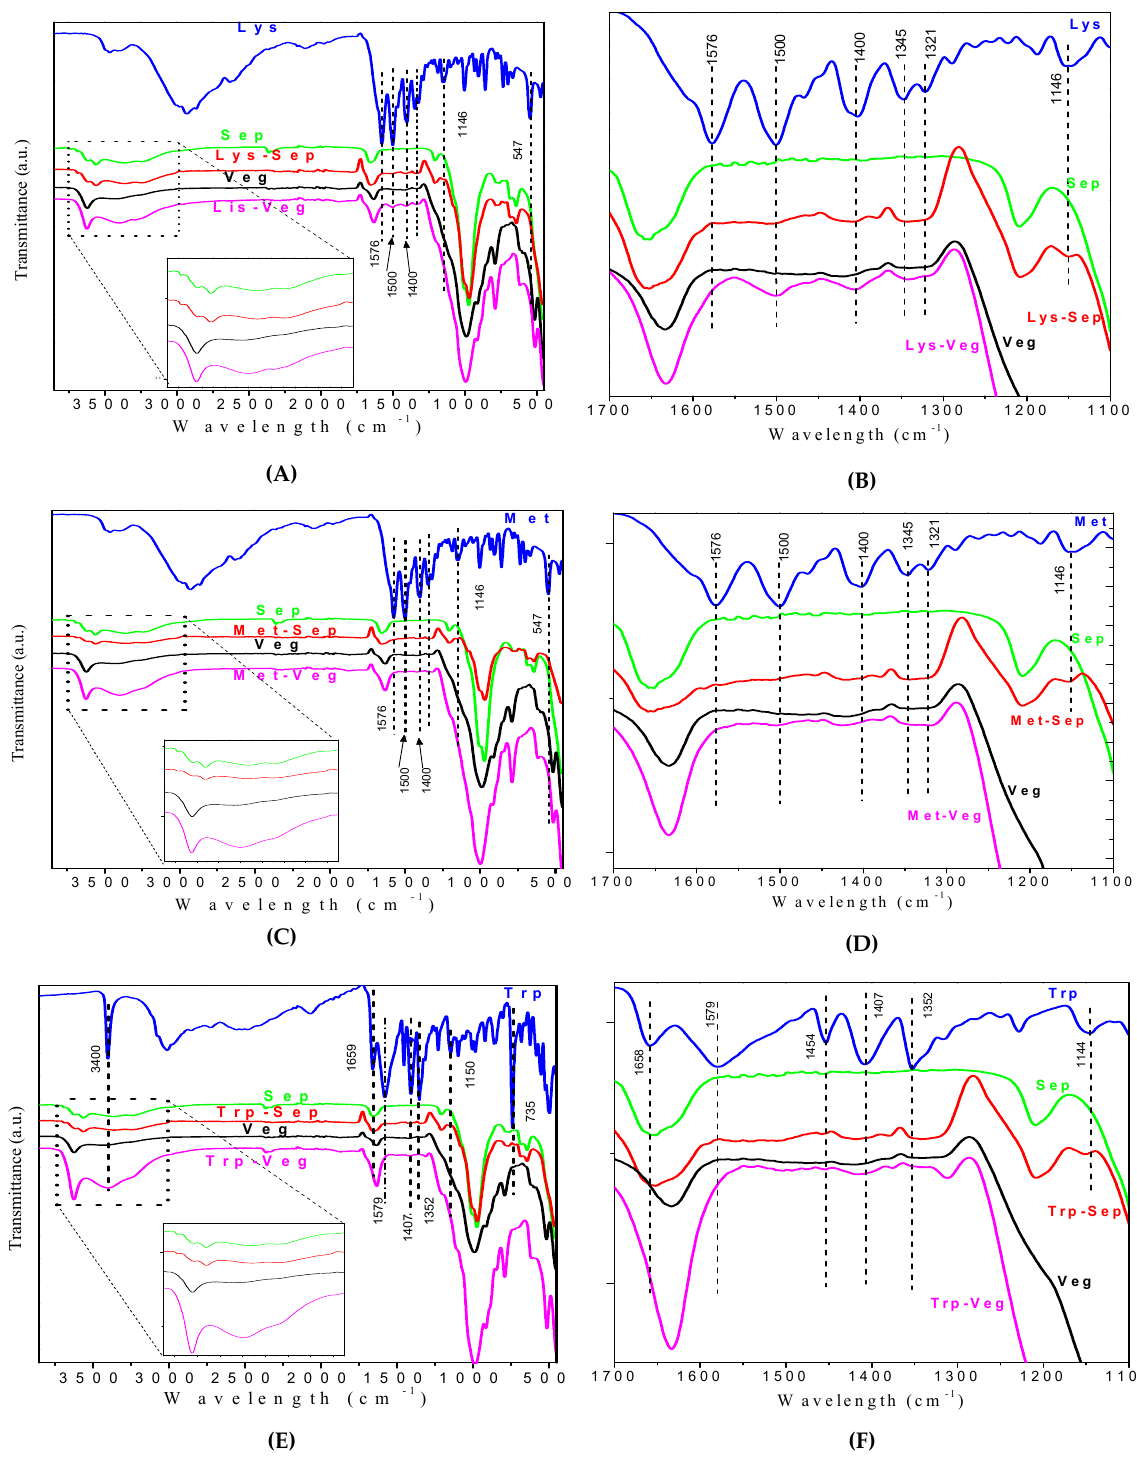
Figure 3. FTIR spectra of samples before and after incorporation of ( A , B ) lysine, ( C , D ) methionine, and ( E , F ) tryptophan accompanied by the spectra of the respective amino acids. Figure 4 illustrates the TG/DTG curves for Sep and Veg before and after amino The L-methionine molecule is similar to the L-lysine molecule, except for the C-S-C acid bond and the presence of only one amino group. These characteristics are not easily de- tectable by FTIR (see Figure 3C,D). The C–S bond usually features weak bands and may overlap. Due to this limitation, there is similarity between the spectra of these amino ac- ids, considering the same attributions mentioned for L-lysine [34,35].